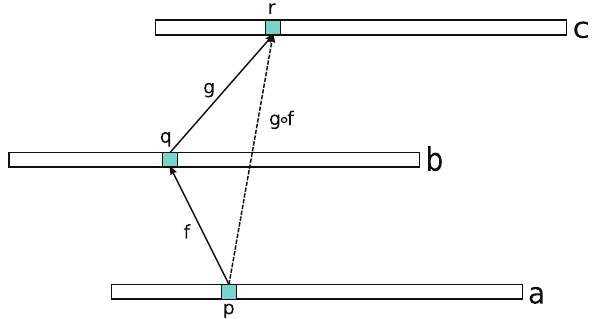
Figure 1. The alignments f maps position p in a to position q in b and the alignment g maps position q in b to r in c . Thus, the composed alignment, g 0 f , maps position p to position r .